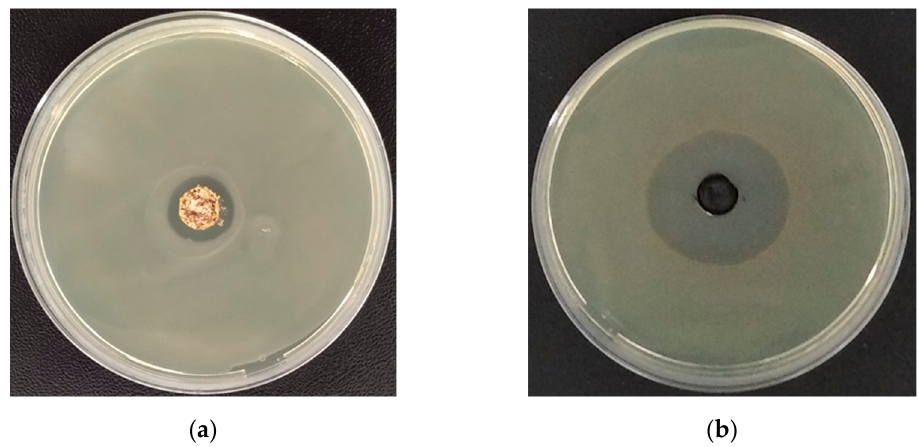
Figure 8. Antibacterial test result of the sample 90TiO 2 .10TeO 2 : ( a ) heat treated at 200 ◦ C and ( b ) 400 ◦ C against E. coli K12